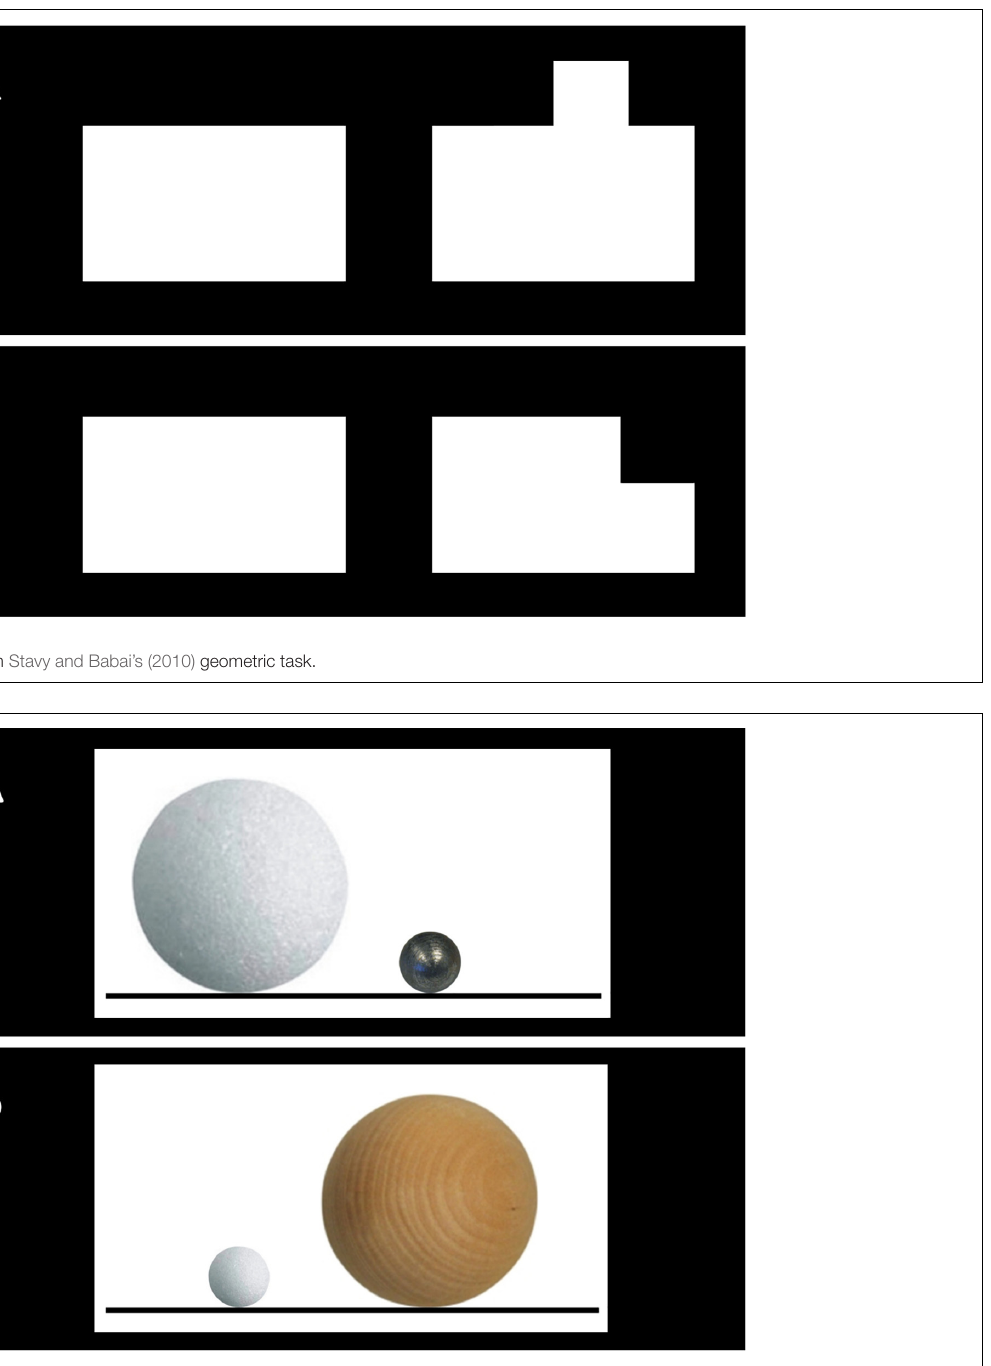
FIGURE 2 | Examples of stimuli from Potvin et al. (2014) buoyancy